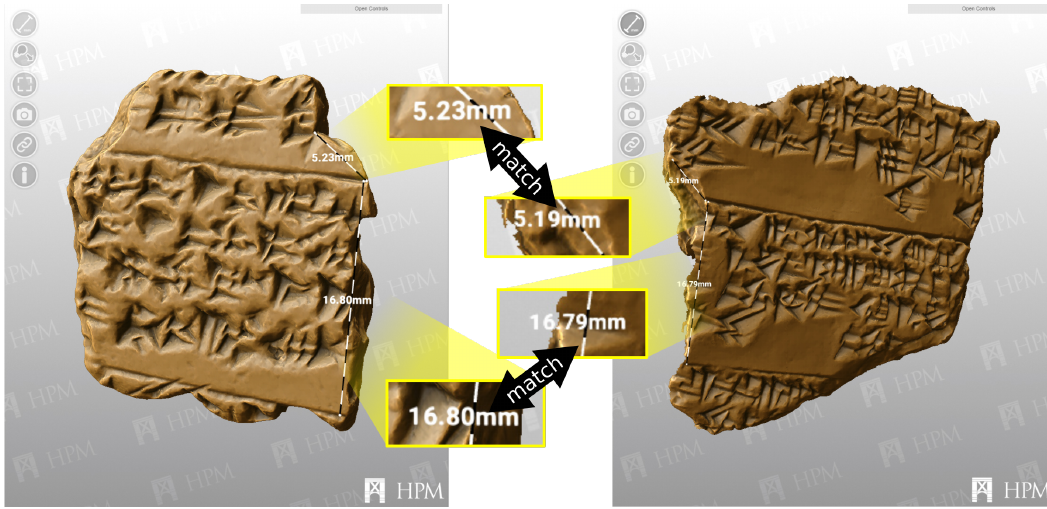
Figure 8. Comparing feature distances on fracture faces in two concurrent instances of the 3D viewer for joining fragments Bo69/331 and Bo8060.